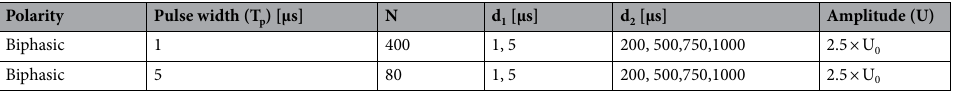
Table 2. Additional biphasic pulse protocols delivered. All biphasic pulse protocols have equal total on-time, i.e., N × 2Tp = 800 µs. Tp pulse width; N number of pulses; d1 interphase delay; d2 interpulse